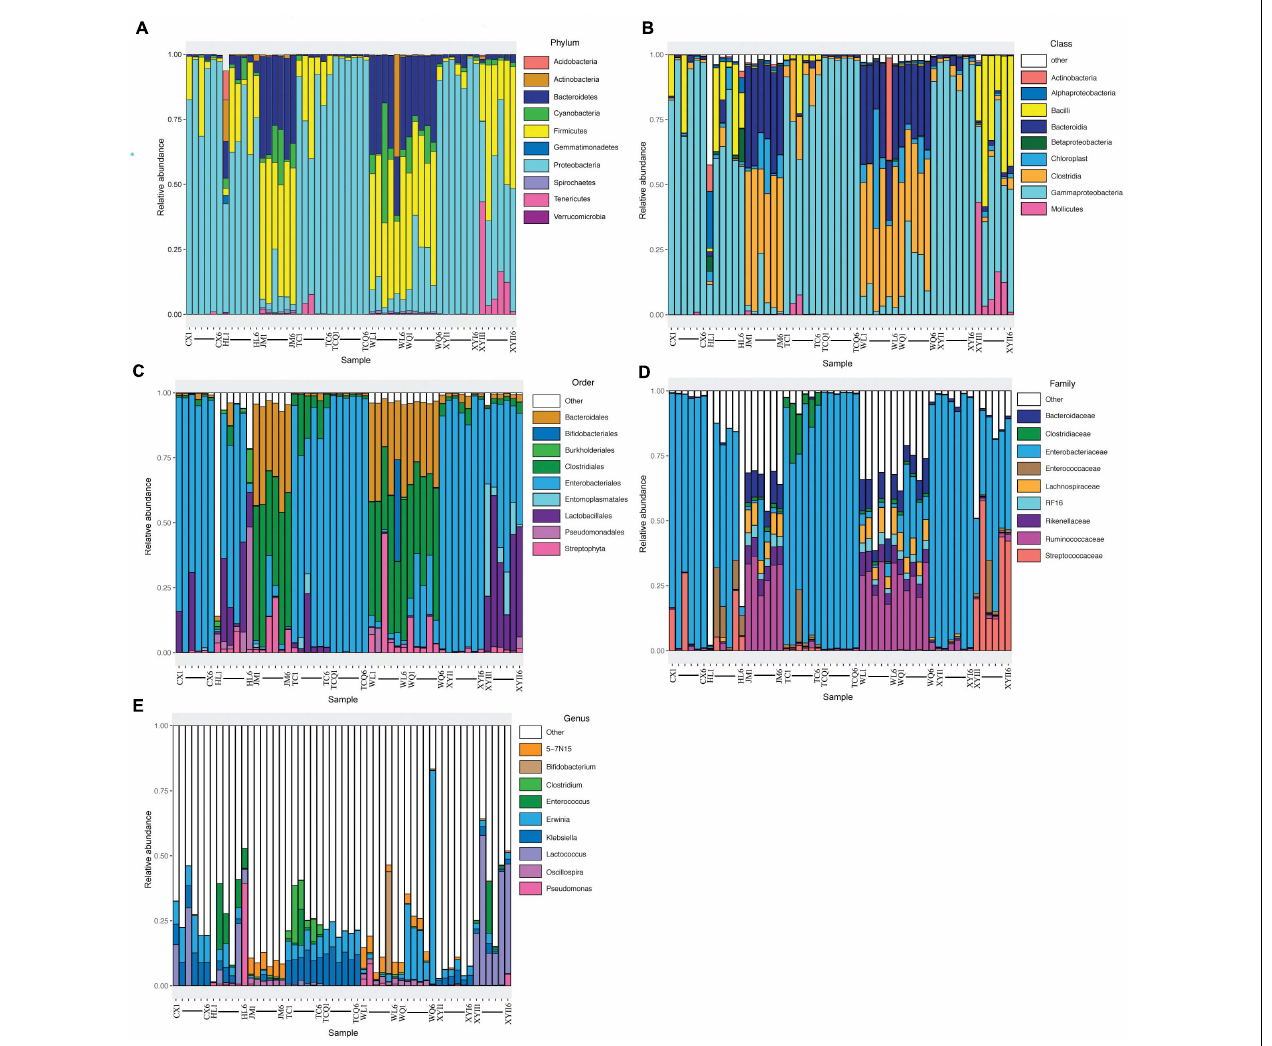
FIGURE 3 | Top 10 phyla (class/order/family/genus) composition of microbiota. Each bar represents a sample, and each color represents a phylum (class/order/family/genus). Low relative abundance taxa and unclassified microbes are grouped into “Other.” (A) The top 10 phyla composition of microbiota. (B) The top 10 family composition of microbiota. (C) The top 10 class composition of microbiota. (D) The top 10 order composition of microbiota. (E) The top 10 genus composition of microbiota.